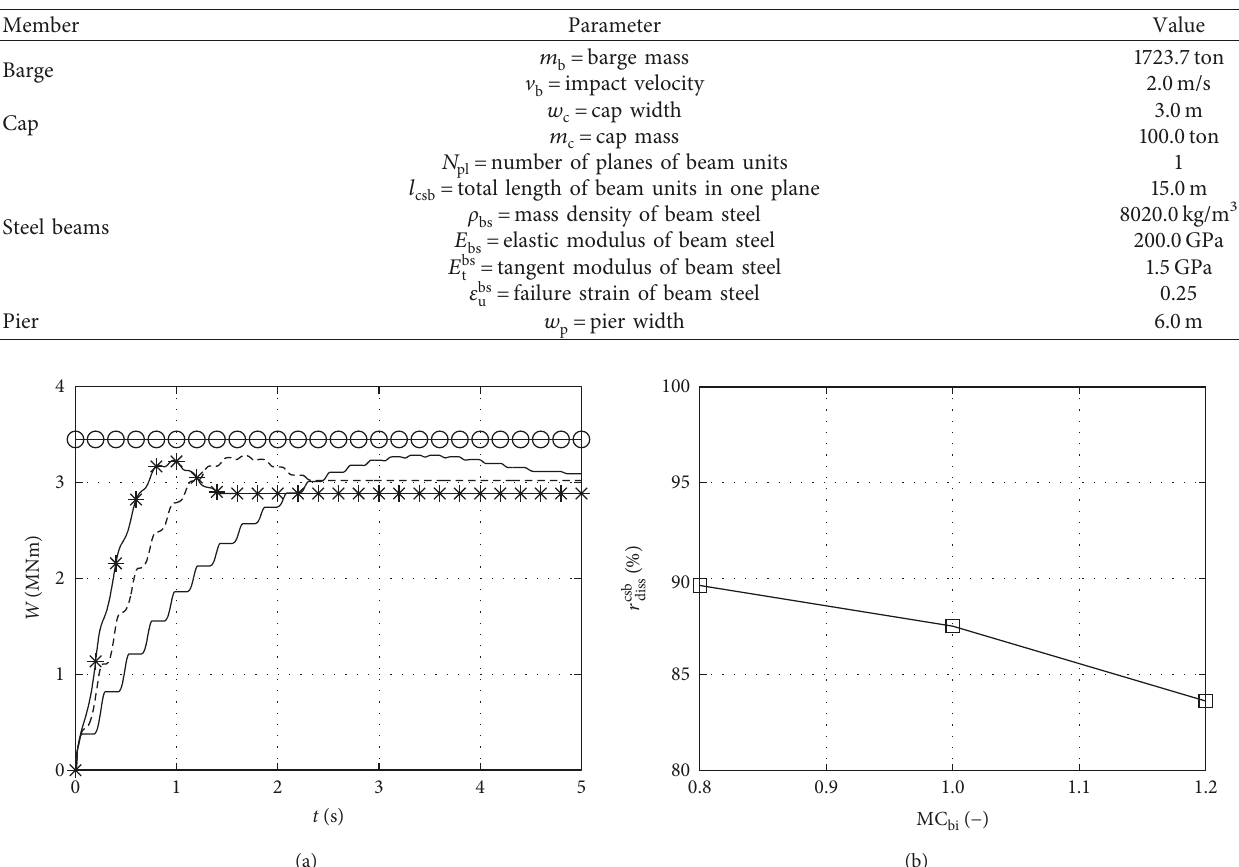
Figure 6: Simplified impact model based on CMM for dynamic analysis of the proposed device subjected to barge impact. Table 1: Prespecified parameters for parametric studies of the device.